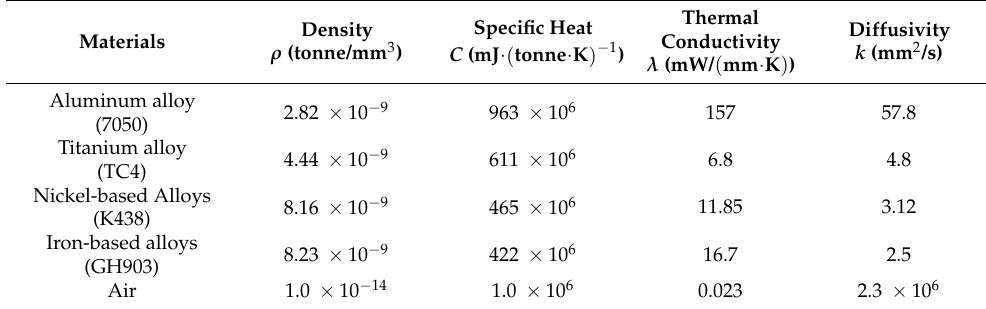
Figure 3. Analysis of temperature response based on circular Gaussian pulse excitation: ( a ) Temperature distribution along the y-direction of different materials; ( b ) Temperature gradient distribution of different materials along the y-direction; ( c ) Temperature distribution along the y-direction at different times; ( d ) Temperature distribution along the y-direction of different Q 0 . Table 1. Thermodynamic parameters of commonly used repair materials.